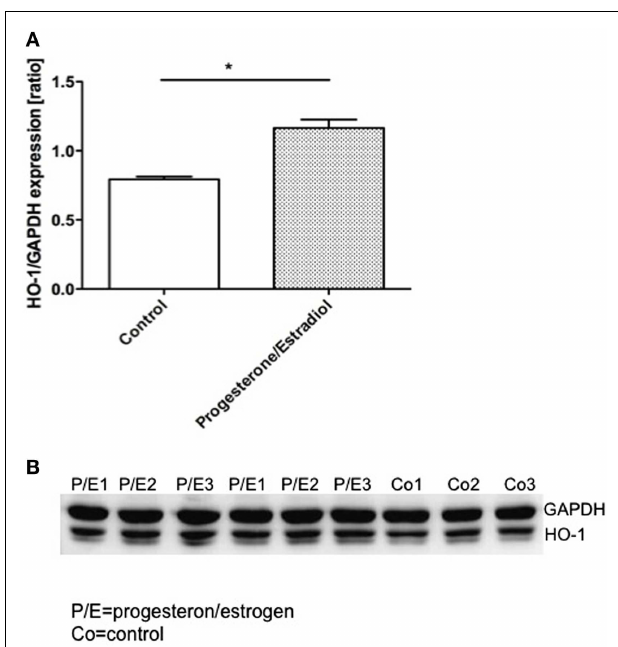
FIGURE 4 |The representative results of three in vitro experiments in whichAN3 cells were cultured in the presence or absence of estrogen (E 2 ) and progesterone (P 4 ) for 24h . (A) The levels of HO-1 relative to GAPDH were elevated in the cells treated with hormones compared to the controls. (B) Representative western blots.The data are expressed as mean ± SEM. * p < 0.05; n = 4, the statistic analysis was performed by two-way